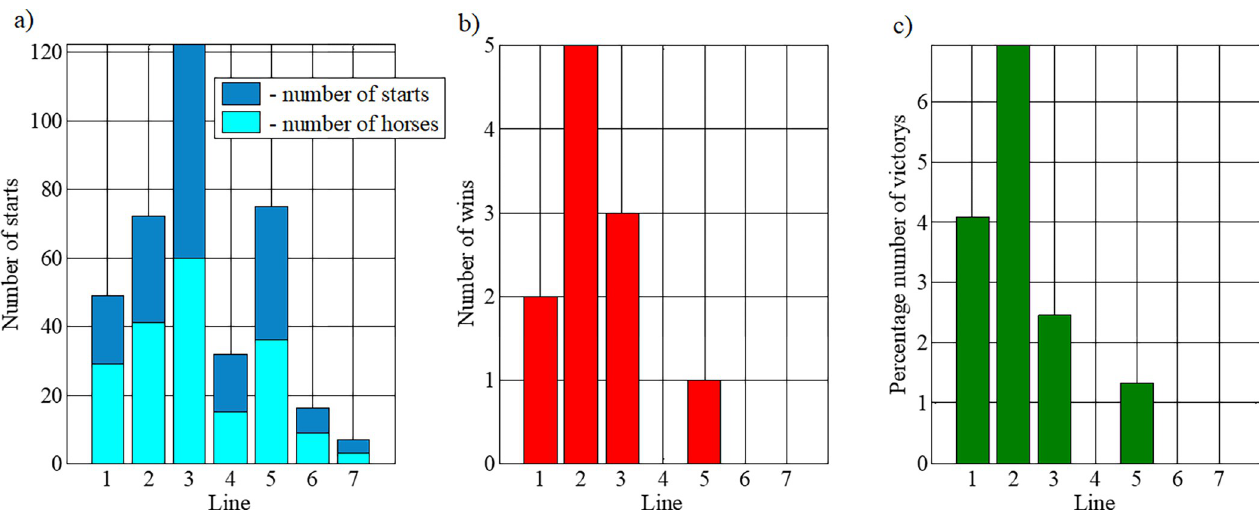
Fig 4. Participation in competitions by line: a) total number of horses from a line participating in competitions, b) number of victories of horses from the line, c) percentage number of victories (number of victories of the line related to the number of competitions). The line were marked with numbers: 1—Gurgul, 2— Goral, 3—Hroby, 4—Ousˇor, 5—Pietrosu, 6—Polan, 7—Prislop.